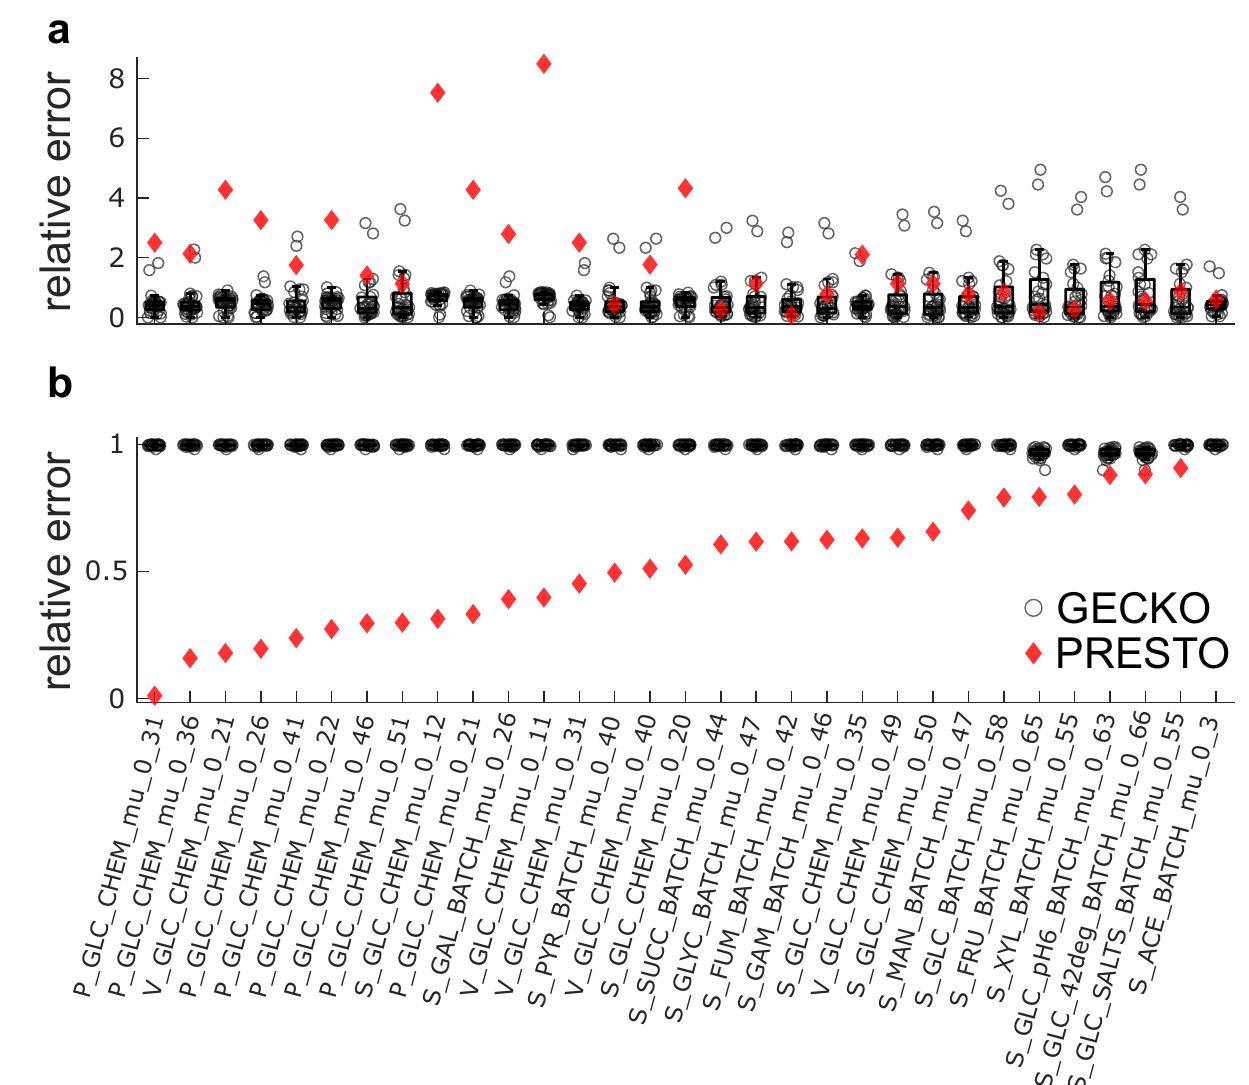
Fig. 4 | Comparison of predicted growth of E. coli from pcGEMs with k cat cor- rections from GECKO and PRESTO. Condition-speci fi c pcGEMs with corrected k cat values generated by the GECKO heuristic were used to predict the speci growth rate for e a ch condition ( a : n =31, b: n =27). The boxplots indicate the distribution of the relative error resulting from each set of condition-speci fi c cor- rected k cat values obtained from the GECKO heuristic. Relative prediction error from each set isindicated by acircle. The red diamonds showthe relative errorsof predicted speci fi c growth rates from the PRESTO model ð λ =10 (cid:1) 5 Þ by using the single set of corrected k cat values in the respective pcGEM. a Only the measured totalproteinpoolwasusedtoconstrainthesolutionandcondition-speci fi cuptake